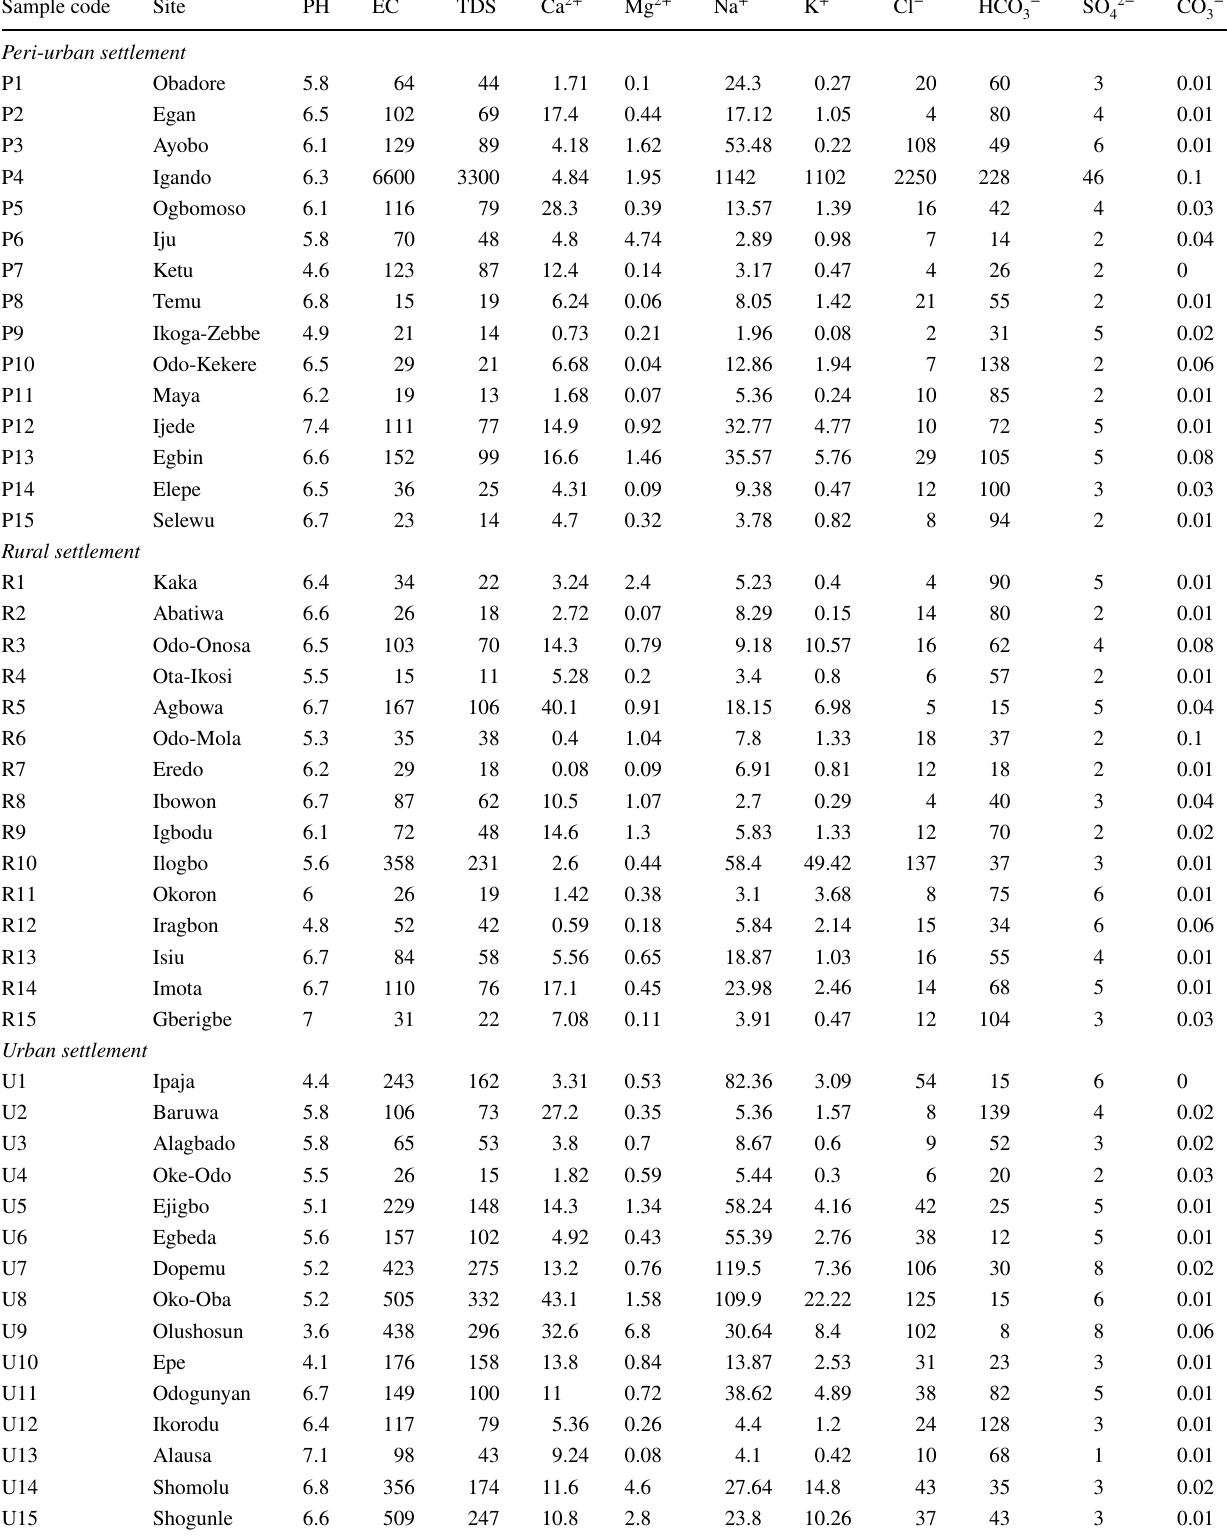
Table 3 Physicochemical parameters of groundwater in the wet season Sample